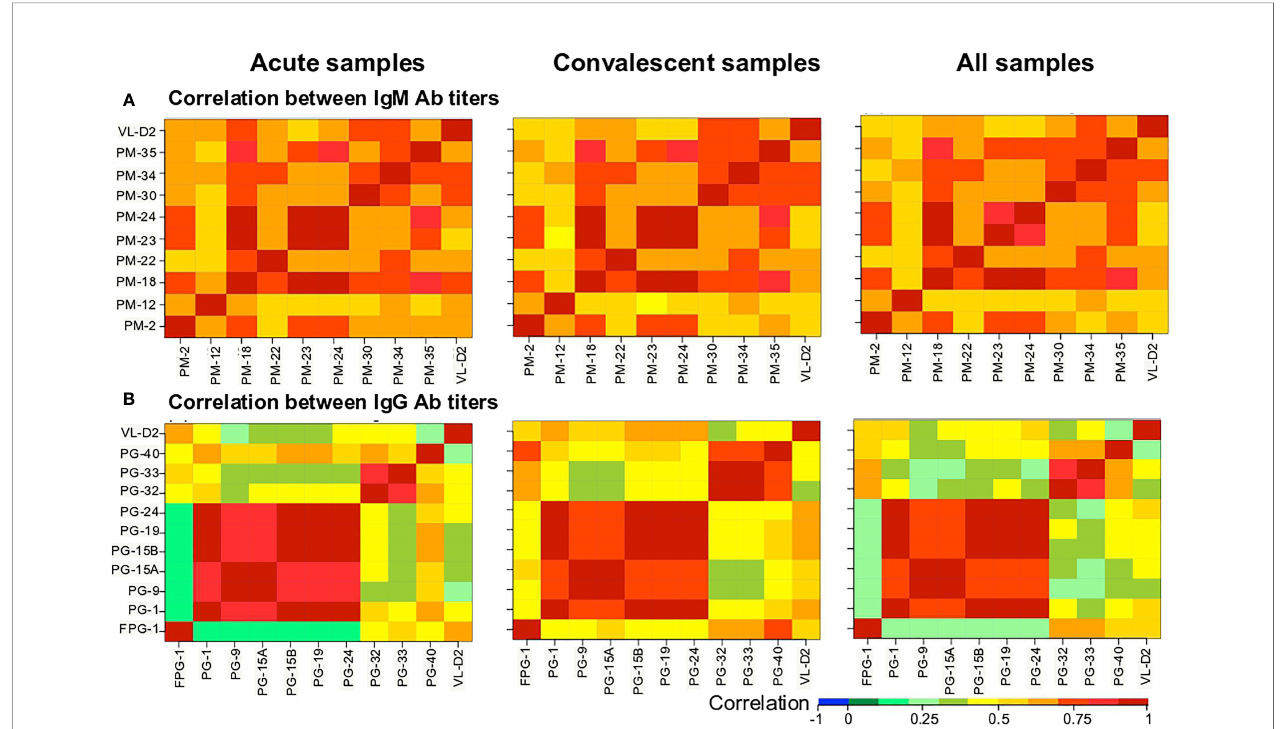
FIGURE 4 | Heatmap of the Spearman ’ s correlation coef fi cient between biomarkers. (A) IgM and (B) IgG Ab responses against the peptides were correlated. Correlation coef fi cients are indicated by the color scale. Blue indicates a negative correlation; red indicates a positive